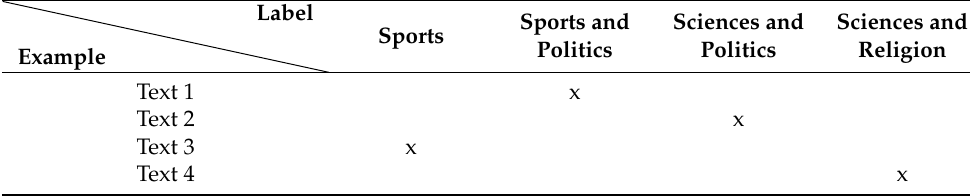
Table 3. Resulting Transformation using Label